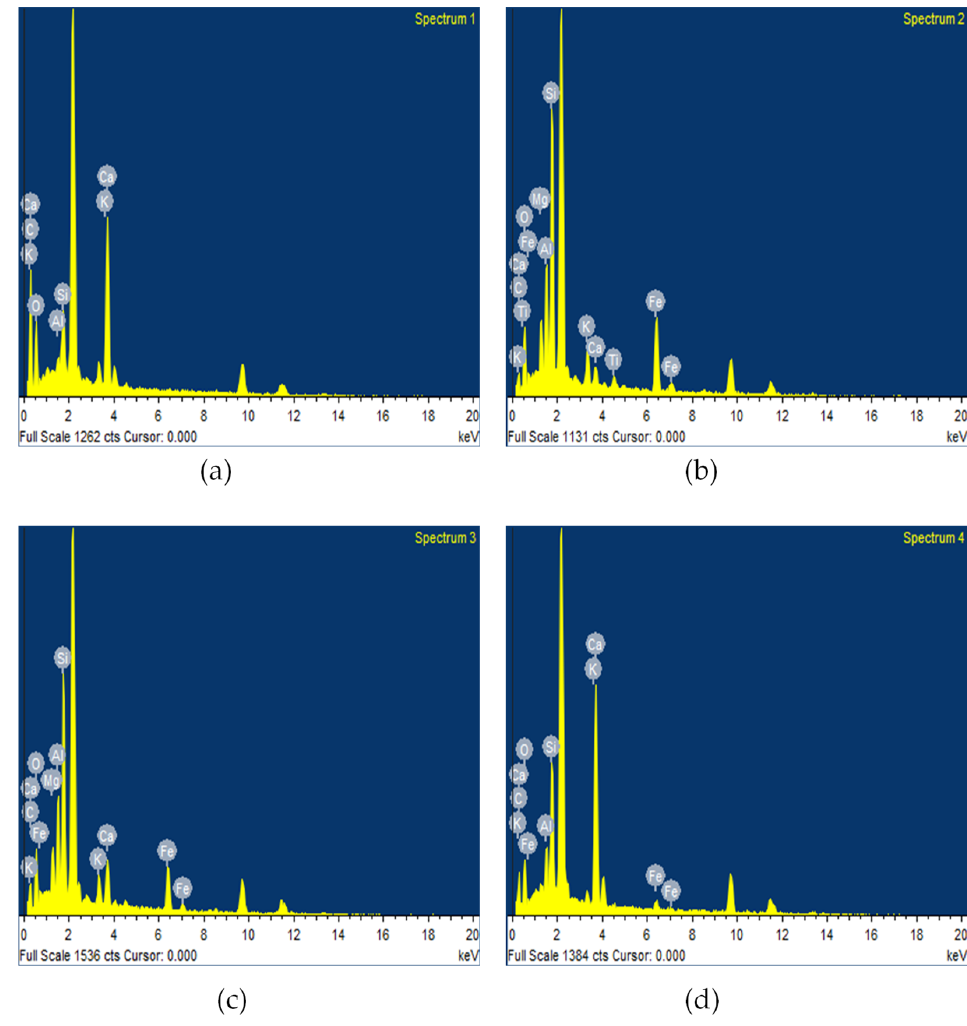
Figure 15. ( a – d ) EDX spectra of the SEM micrograph indicated in Figure 14d. Reproduced with